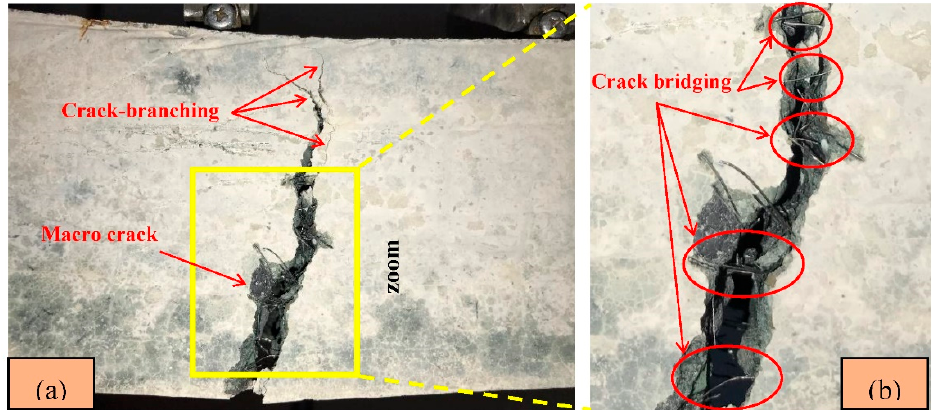
Figure 14. Failure pattern of an RTSF reinforced specimen.